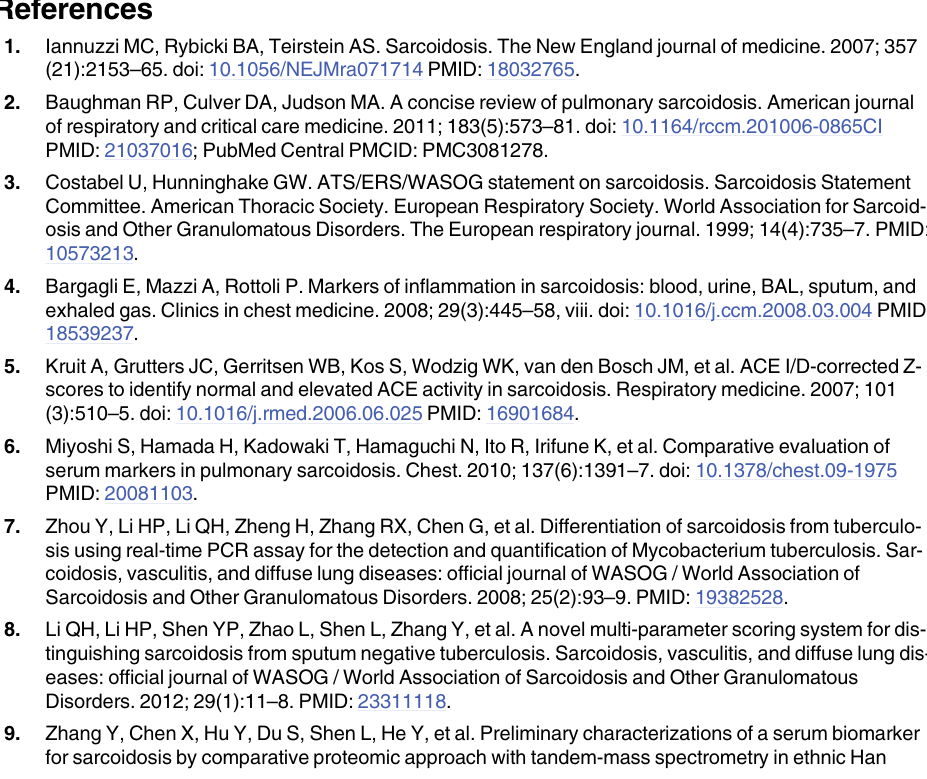
S1 Table. Raw data and P value of 120 kinds of proteins and cytokines in the serum from SA (n = 3) and HC (n = 2)